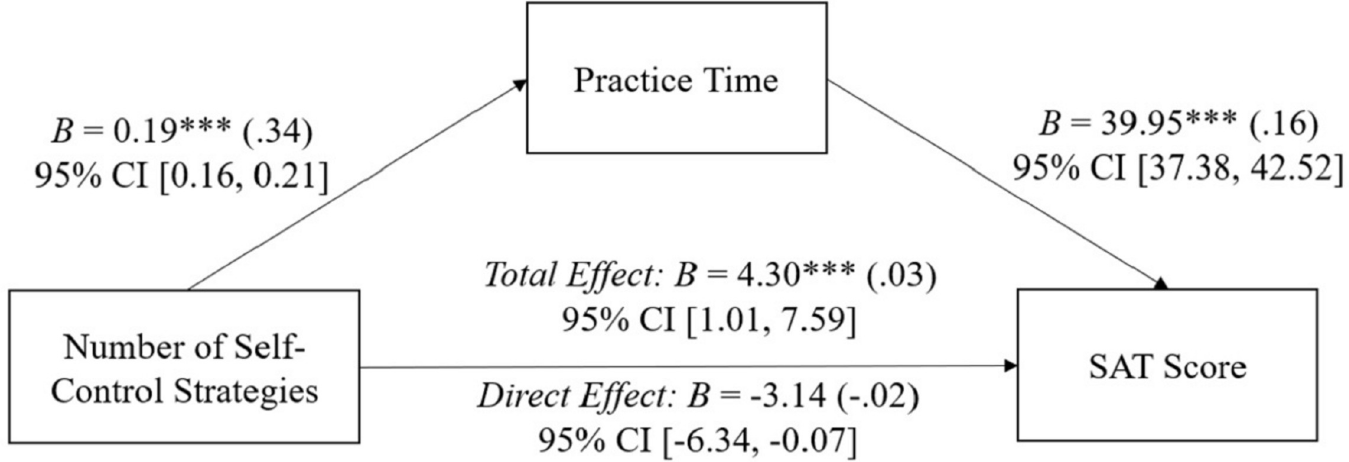
Fig 4. Study 2 practice time mediating the relationship between number of self-control strategies and SAT scores. Study 2 practice time mediates the relationship between the number of self-control strategies and SAT scores. B represents the unstandardized beta coefficient (standardized beta coefficients in parentheses). Covariates include the squared strategic self-control term, students’ PSAT scores, gender, fee waiver status, and ethnicity. ��� p < .001.